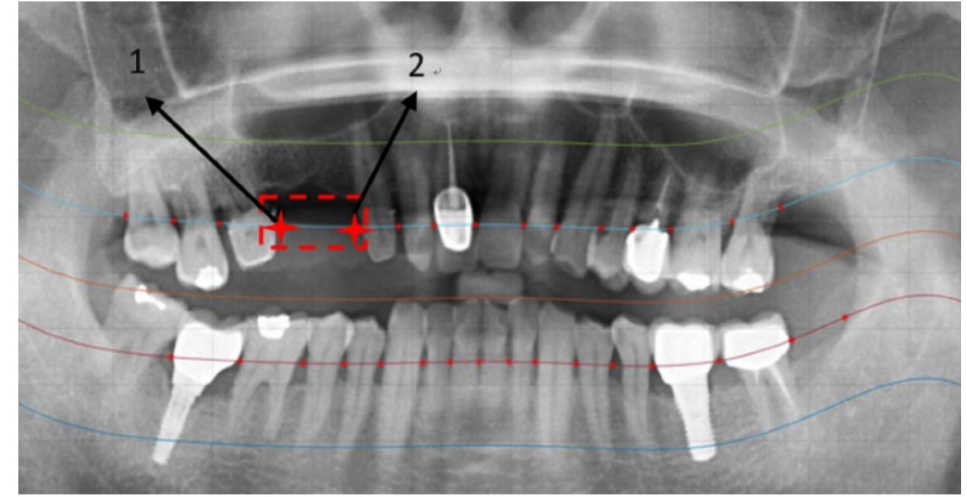
Figure 19. Errors while detecting missing